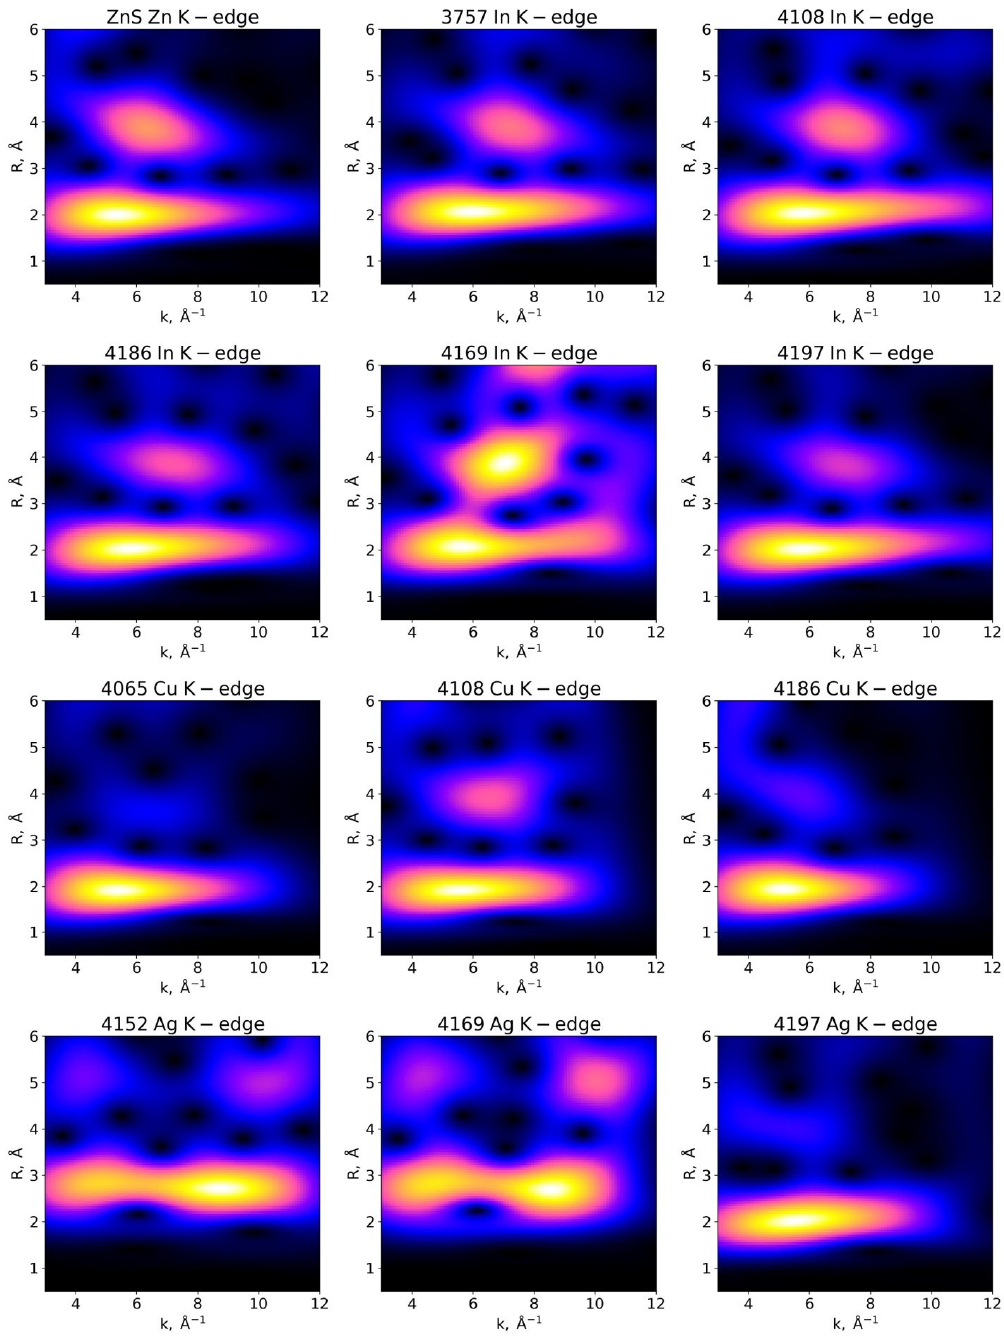
Figure 4. Wavelet transforms (WTs) of the X-ray absorption fine structure spectroscopy (EXAFS) signal (distance R (Å) (not corrected for phase shift) vs. photoelectron wavenumber k (Å − 1 )). Bright colors show regions with a maximum contribution of scattering atoms located at a distance R from the absorber and characterized by a definite value of the photoelectron wavenumber k . The similarity of the WT of ZnS and WTs obtained for all samples at In K -edge (Samples 3757, 4108, 4186, 4169, 4197), Cu K -edge (Samples 4108 and 4186), and Ag K -edge (Sample 4197) imply similar local atomic structures around the admixtures in these samples and that of Zn in sphalerite. The presence of a heavy atom (Ag) in the nearest coordination shell of Ag in Samples 4152 and 4169 is indicated by the contribution at k ~10 Å − 1 and can be interpreted as the formation of inclusions of Ag metal.